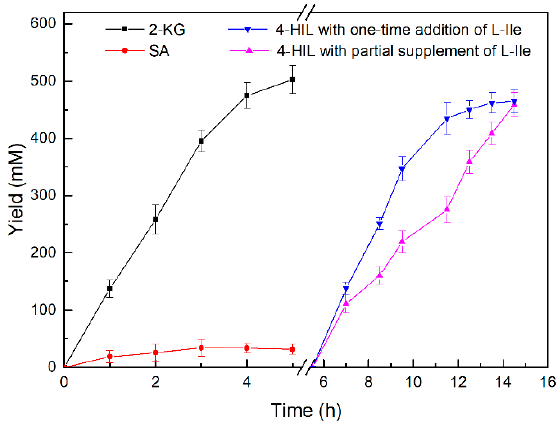
Figure 6. Two-step reaction for 4-HIL production.